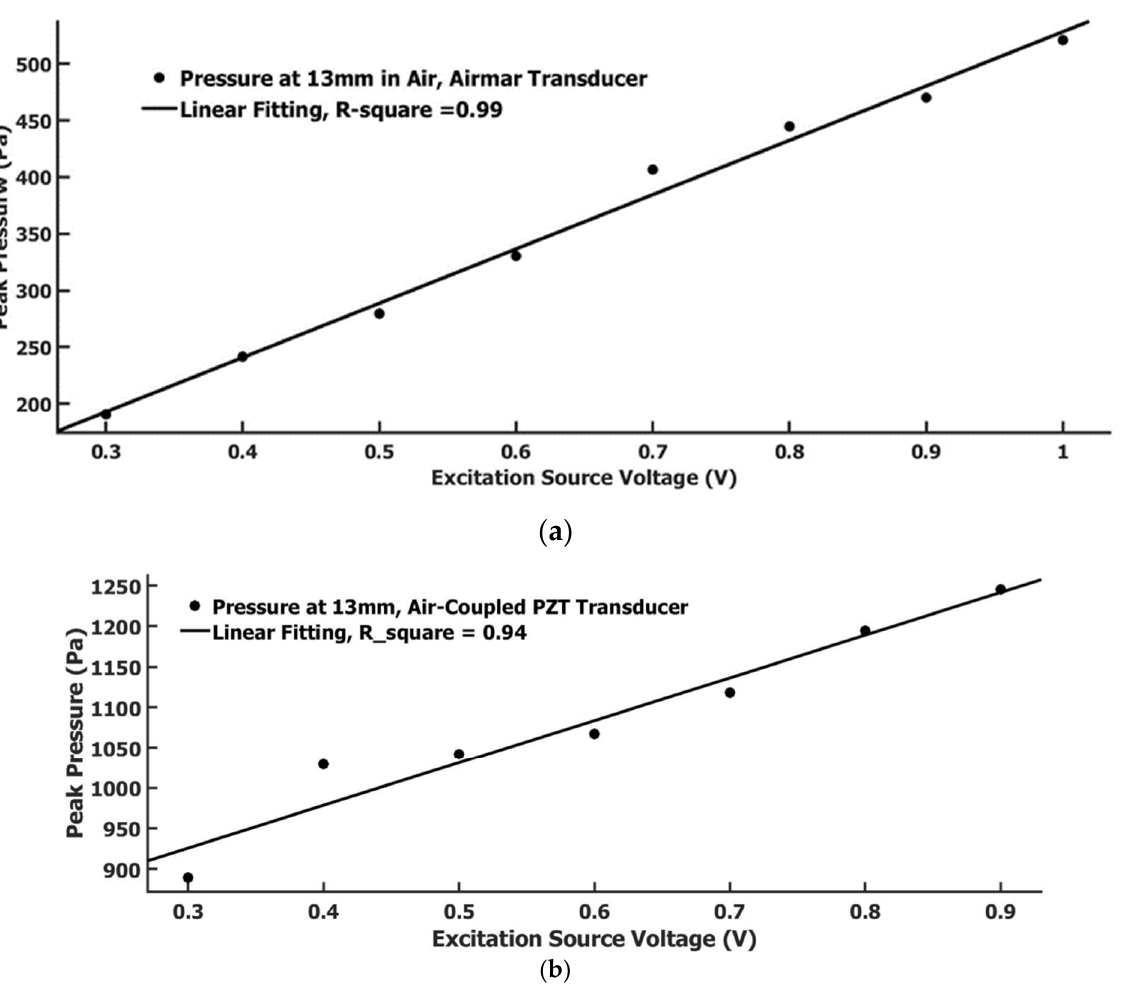
Figure 5. ( a ) The measured pressure under the different excitation peak-to-peak voltage for the Airmar air-coupled transducer; ( b ) The measured pressure under the different excitation peak-to- peak voltage for the focused air-coupled PZT transducer.